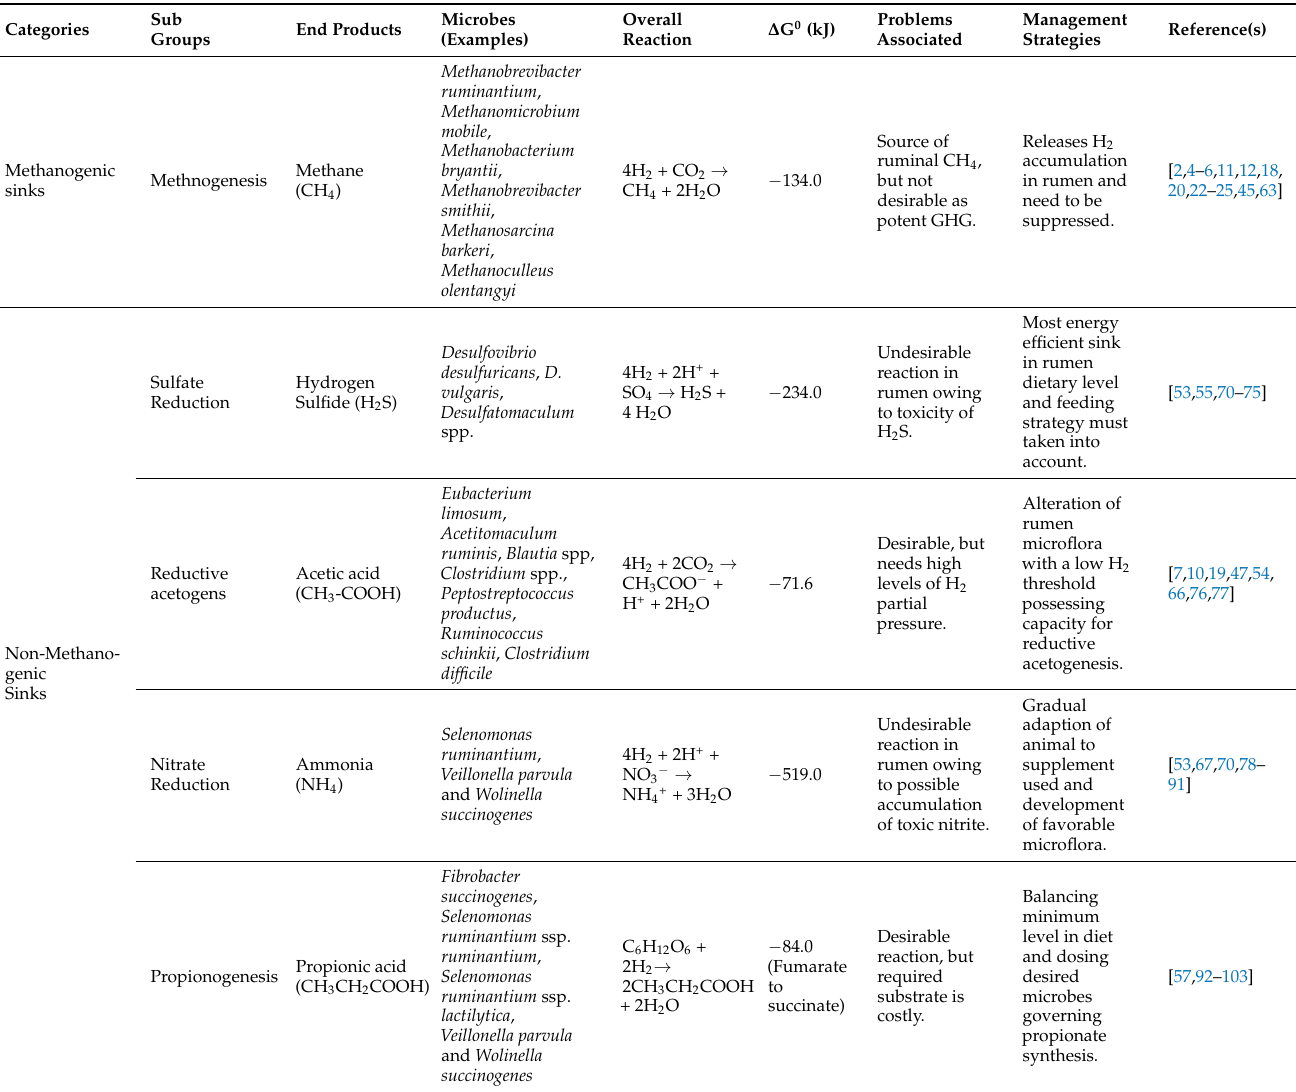
Table 1. H 2 sequestration sinks, involved mechanisms, associated problems and future